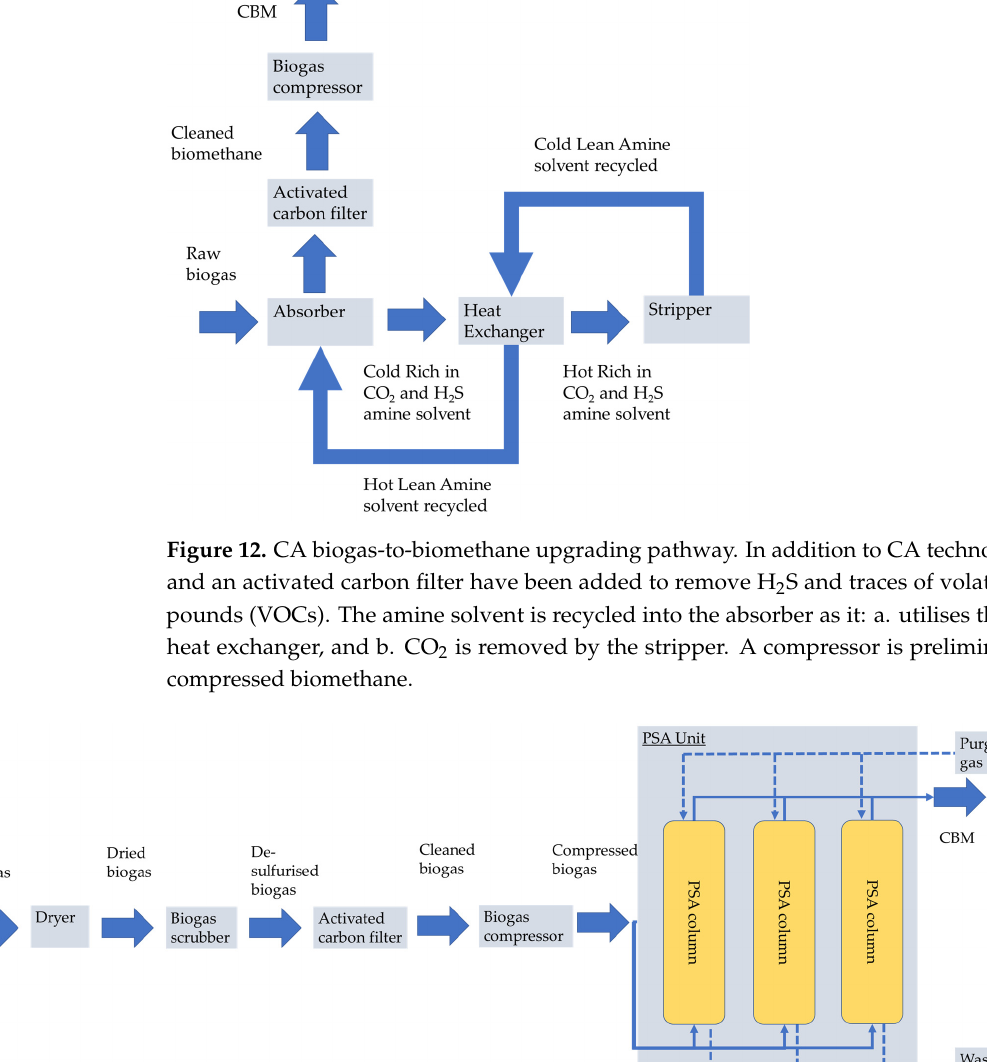
Figure 13. PSA biogas-to-biomethane upgrading pathway. In addition to PSA technology, a dryer, a scrubber, and an activated carbon filter have been added to remove moisture, H 2 S, and traces of volatile organic compounds (VOCs). The PSA columns are in connected in series and form the PSA unit.